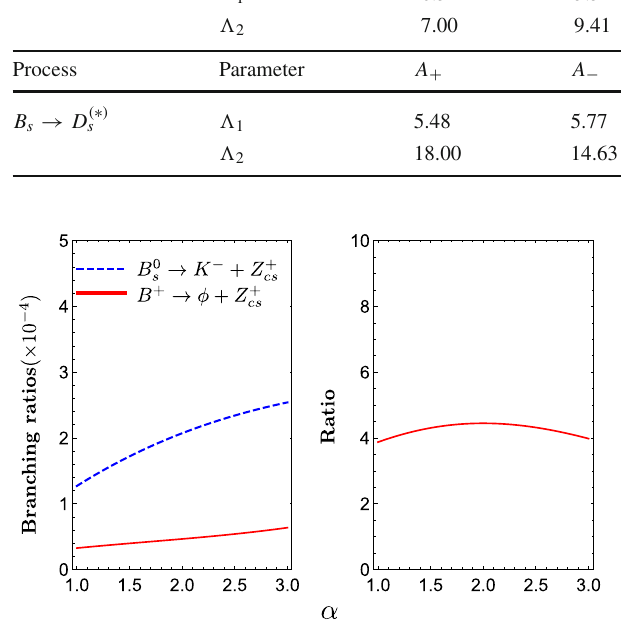
Fig. 4 Branchingratiosof B + → φ Z + cs and B 0 s → K − Z + cs (leftpanel) and their ratio (right panel) depending on parameter